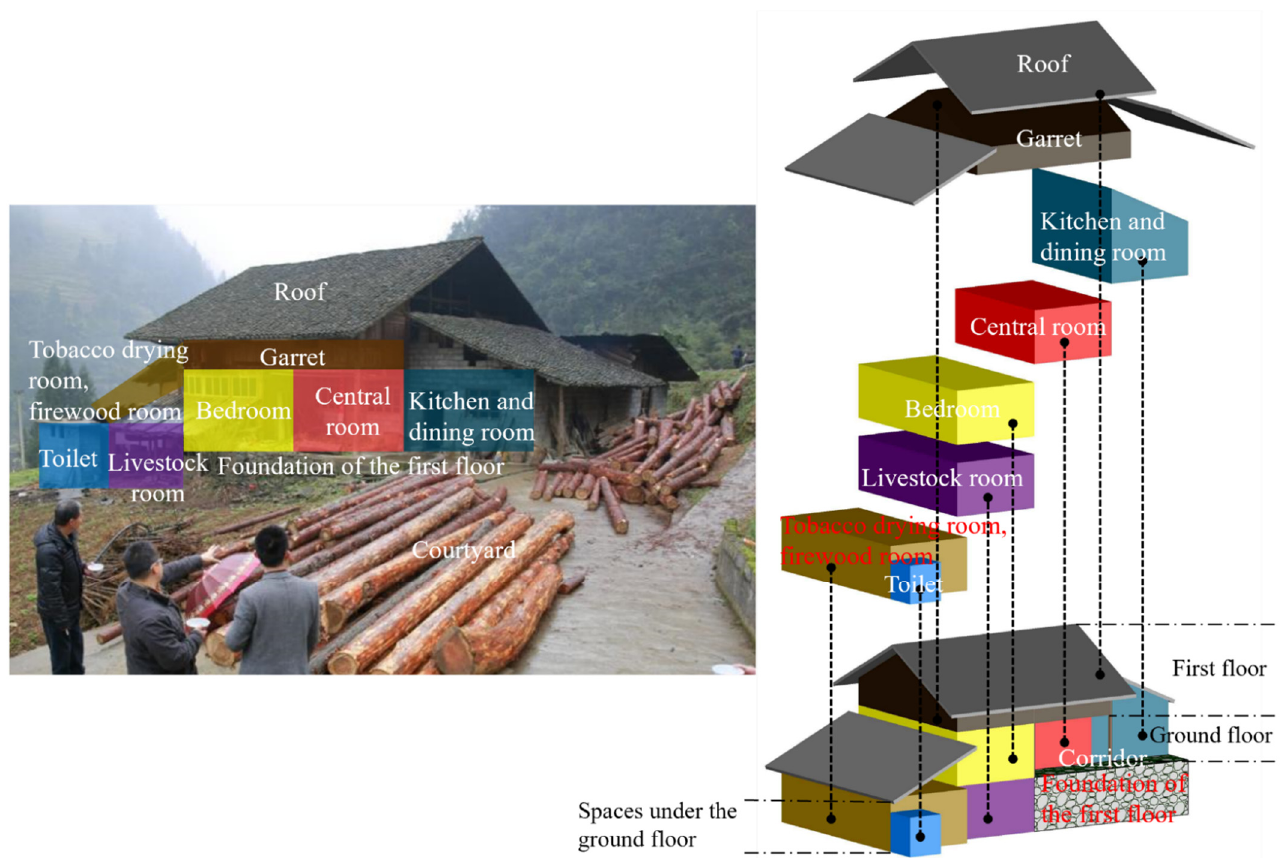
Figure 5. The internal land use and spatial structure of homesteads before the operation of homestays in Xiniu village.